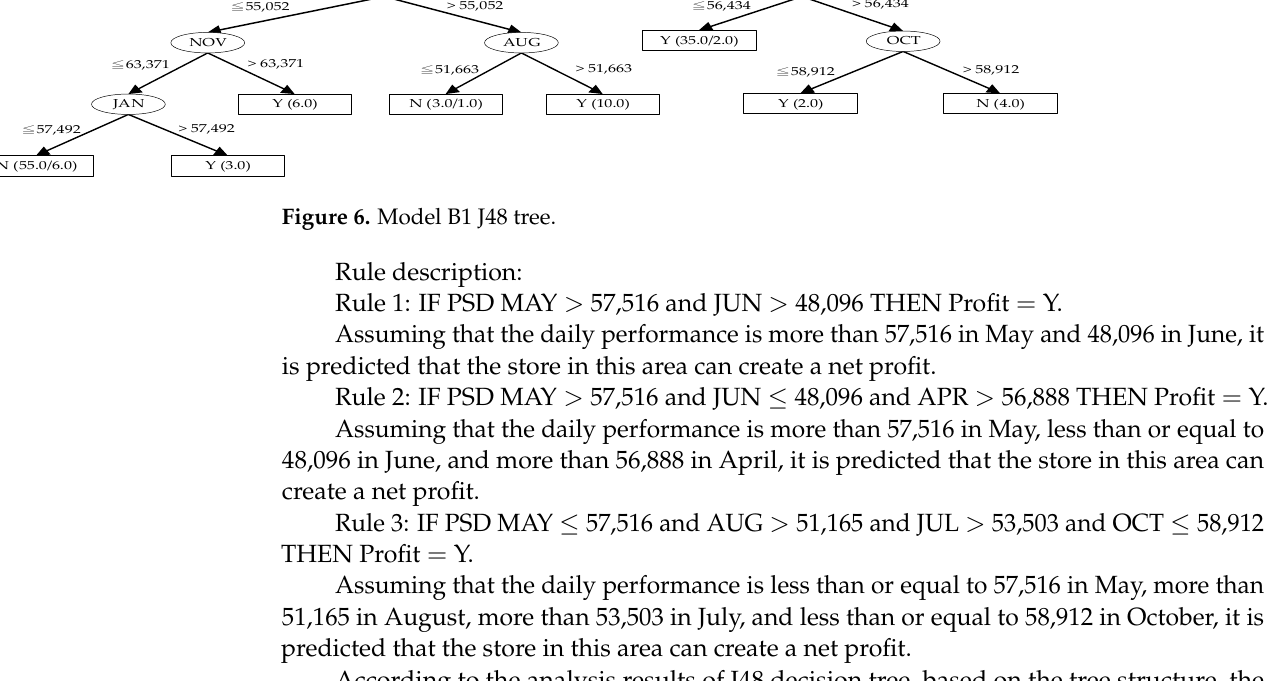
Figure 6. Model B1 J48 tree.